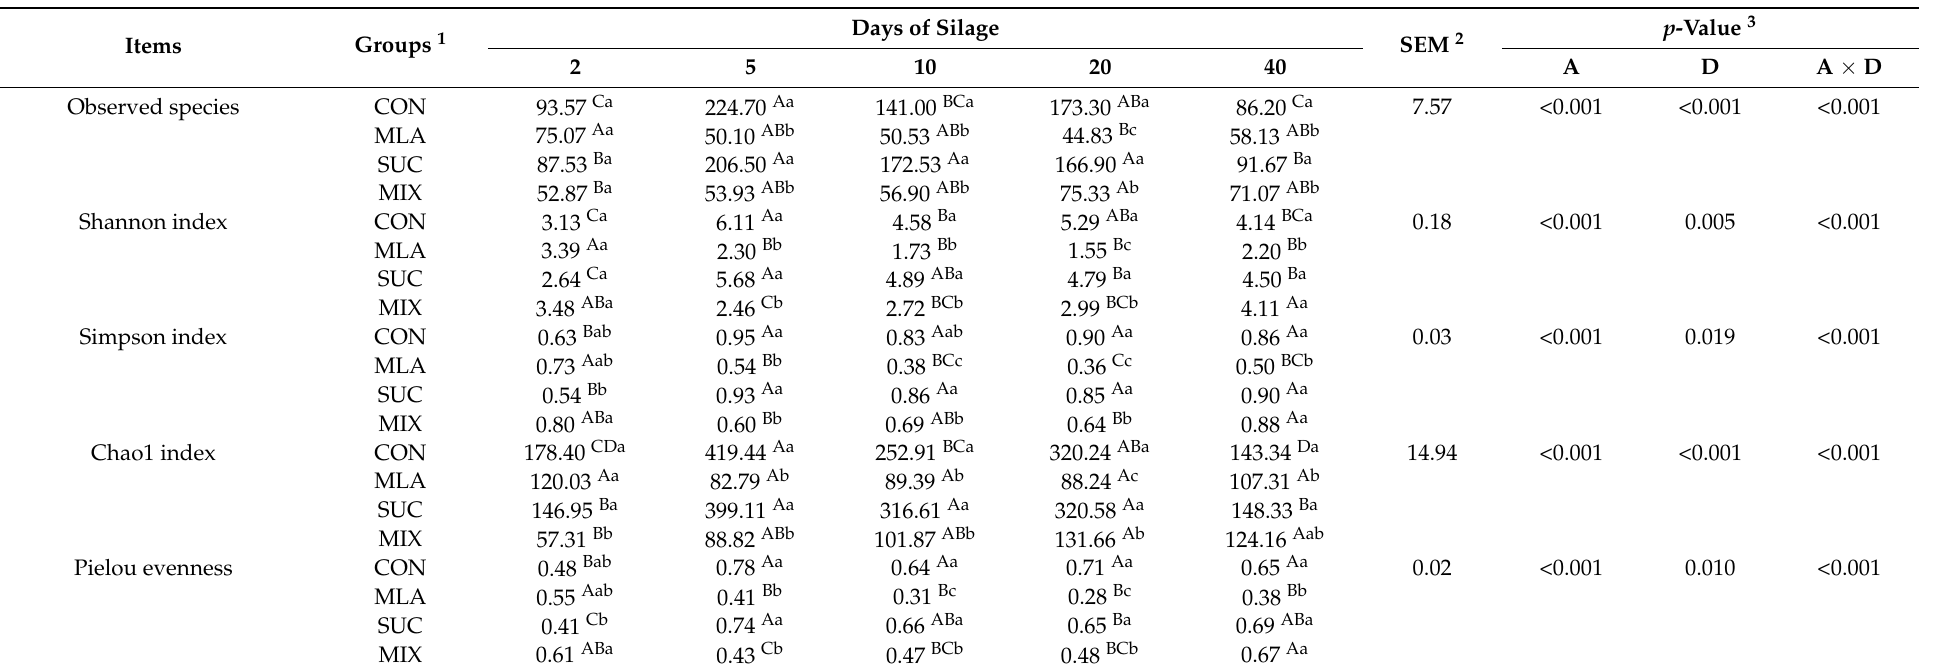
Table 5. Alpha-diversity of bacterial communities of Moringa oleifera leaves silage treated with malic acid and